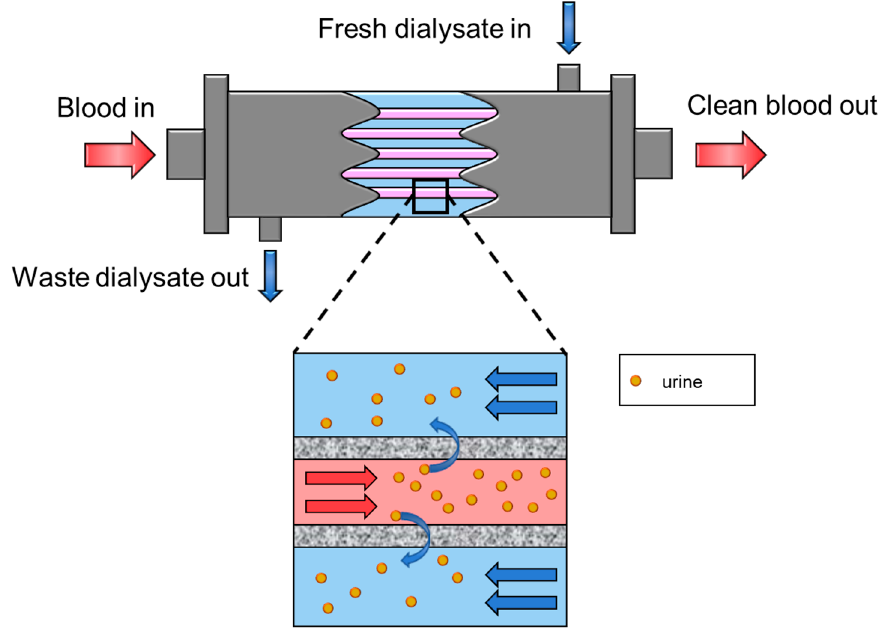
Figure 11. Membrane-based artificial kidney schematic.